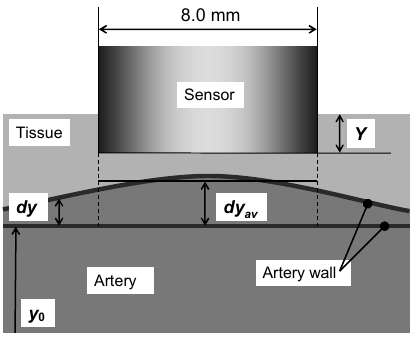
Fig. 4 Schematic of deformation of arterial wall and compression of subcutaneous tissue.